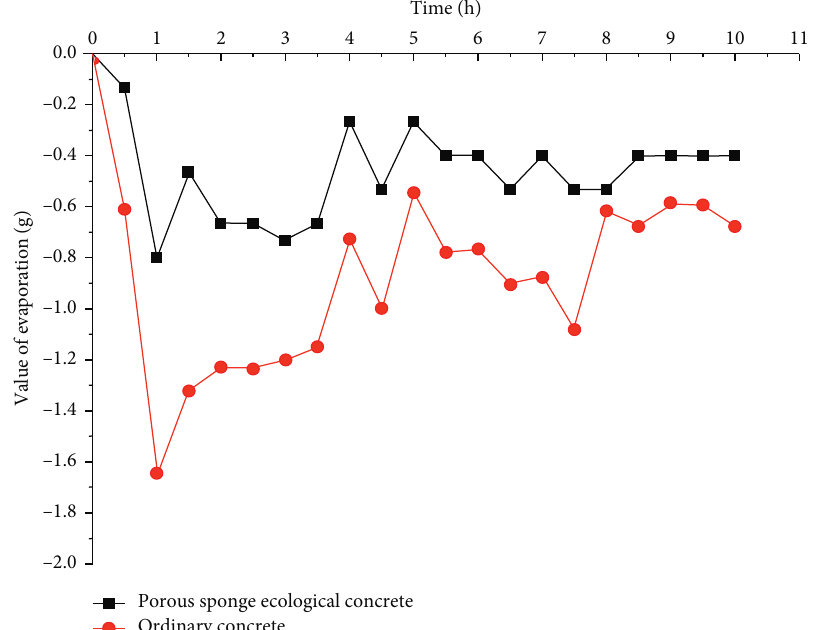
Figure 10: Average water evaporation per unit mass per unit time under different working conditions (40 ° C).